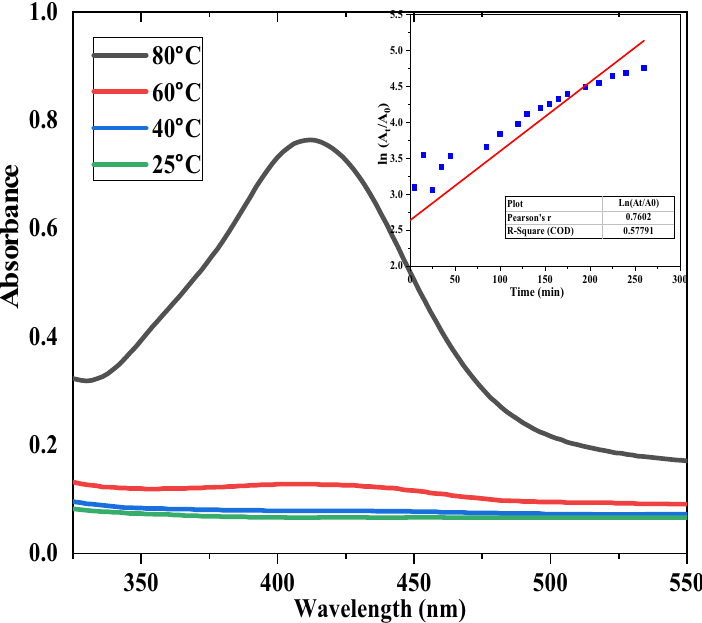
Figure 3. Effect of Temperature on the formation of AgNPs ( A ). Inset First order plot ( B ) of formation of AgNPs.